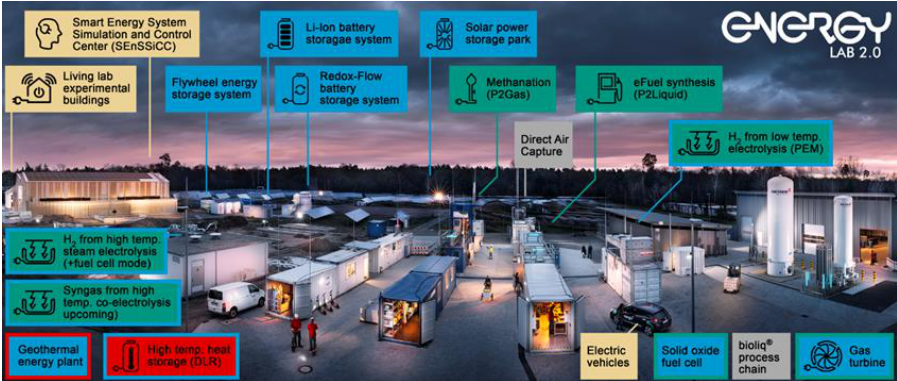
Figure 12. Energy Lab 2.0 at Karlsruhe Institute of Technology (KIT), Karlsruhe, Germany; Photo: M. Breig and A. Bramsiepe (KIT).